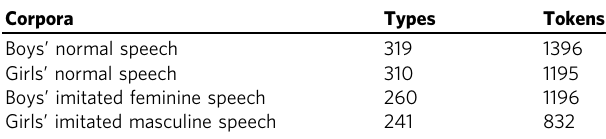
Table 2 Types and tokens in each